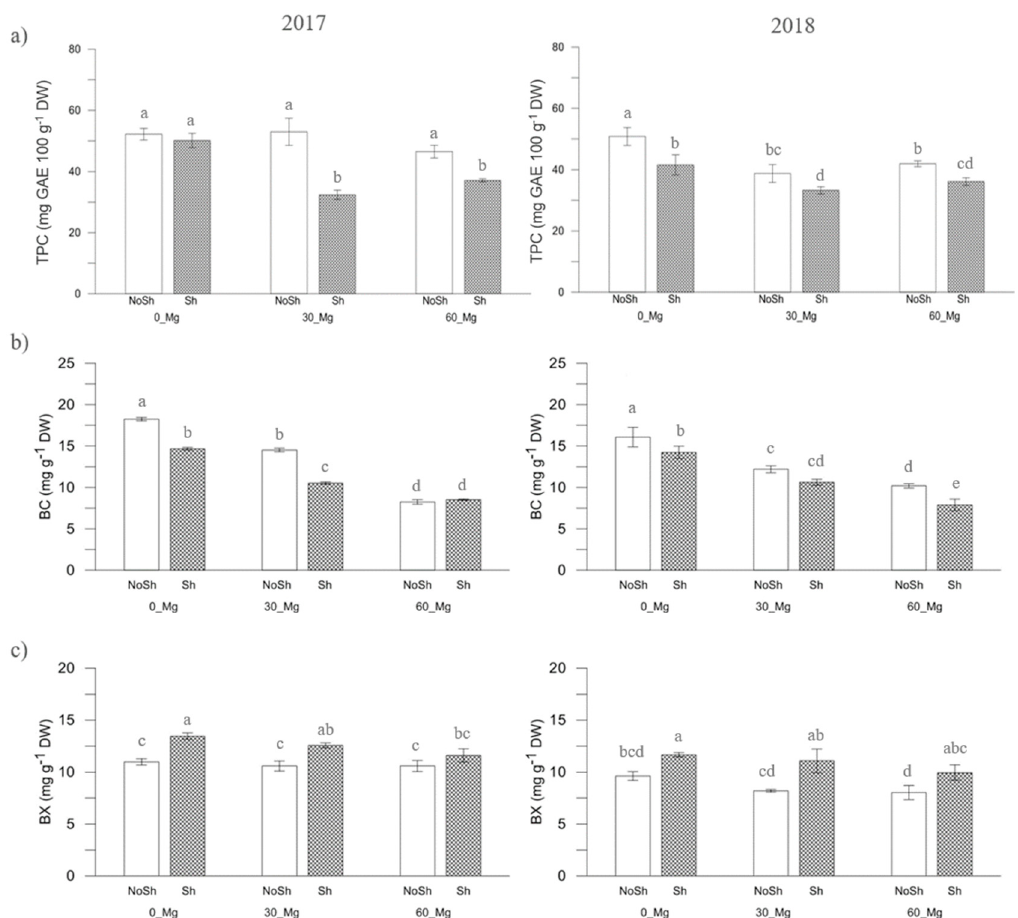
Figure 1. ( a ) Total polyphenols content (TPC, mg gallic acid equivalents (GAE) 100 g − 1 dry weight, DW); ( b ) betacyanins (BC, mg g − 1 DW) and ( c ) betaxanthins (BX, mg g − 1 DW) content in the storage roots of red beet plants subjected to two levels of photosynthetically active radiation (PAR) availability (100% PAR availability: Full Light, FL; 50% PAR availability: Light Reduction, LR) and three magnesium (Mg) application rates (0 kg ha − 1 of Mg: MG_0; 30 kg ha − 1 of Mg: MG_30; 60 kg ha − 1 of Mg: MG_60) during two growing cycles (2017 and 2018). Average values ± standard errors are depicted; n = 3 independent replicates. Di ff erent letters stand for statistically significantly di ff erences at p ≤ 0.05 (Fisher’s LSD